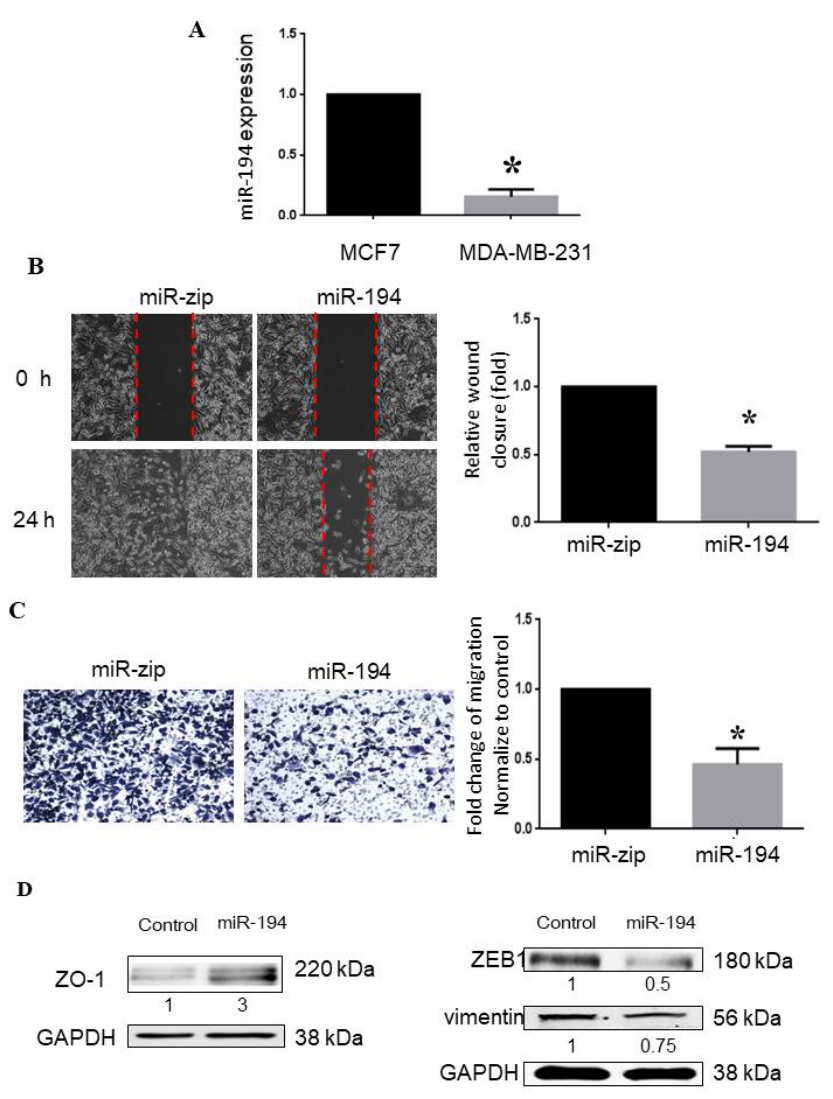
Figure 4. miRNA-194-5p inhibits the migration of breast cancer cells: ( A ) The expression levels of miR-194-5p were assessed by RT-qPCR in metastatic MDA-MB-231 cells and MCF7 cells. The relative miR-194-5p expression was normalized to U6 expression. ( B ) Wound-healing assay was used to evaluate whether miR-194-5p inhibited cell migration ability. MDA-MB-231 cells were observed at the indicated time points. Images of the wound gap were photographed at 0 and 24 h (at 50 × magnification). Red dotted lines represented the baseline. ( C ) Cell migration abilities were evaluated by Trans-well migration assays in MDA-MB-231 cells (at 200 × magnification). *, p < 0.05; and ( D ) the epithelial marker ZO-1 and the mesenchymal markers ZEB1 and vimentin were detected by Western blotting in transfected cells. ZO-1 protein levels were increased, while ZEB1 and vimentin protein levels were decreased in miR-194-5p transfected cells, compared with the empty vector group. miR-194-5p modulated the expression of EMT markers in MDA-MB-231 cells. The results are expressed as the mean ± SD (n =